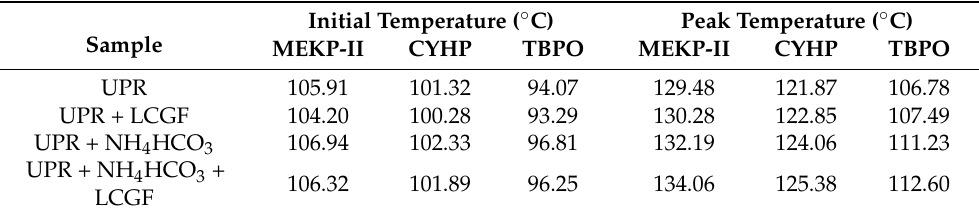
Table 4. Different initial temperatures and different peak temperatures of different samples with the presence of different initiators and the same accelerator.